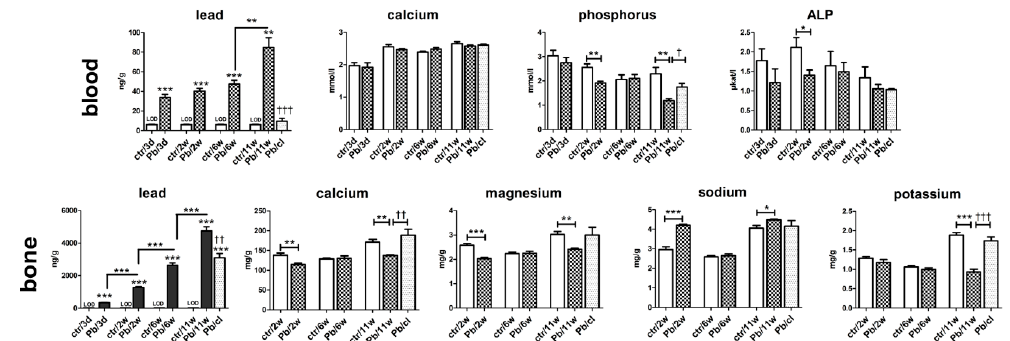
Figure 4. The concentrations of selected elements and alkaline phosphatase (ALP) in the blood and bone after Pb(NO 3 ) 2 NP inhalation. The graphs of selected elements (Pb, Ca, P, Mg, Na, K) and ALP in the blood and / or in the bone tissue. The graphs values indicate average ± SD for 5 mice / group; * p < 0.05, ** p < 0.01, *** p < 0.001 compared with the corresponding control group (ctr) or between adjacent time points, and † p < 0.05, †† p < 0.01, and ††† p < 0.001 compared with the corresponding Pb(NO 3 ) 2 NP group by unpaired t -test. The concentrations of Pb in controls were below limit of detection (LOD). LOD for Pb in the blood was 6, 11, 4 and 3 ng / g Pb at individual time points, for Pb in the bone 21 ng / g